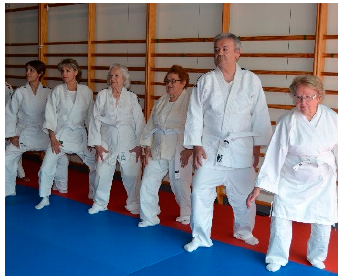
Figure 5. Softened defensive stance.